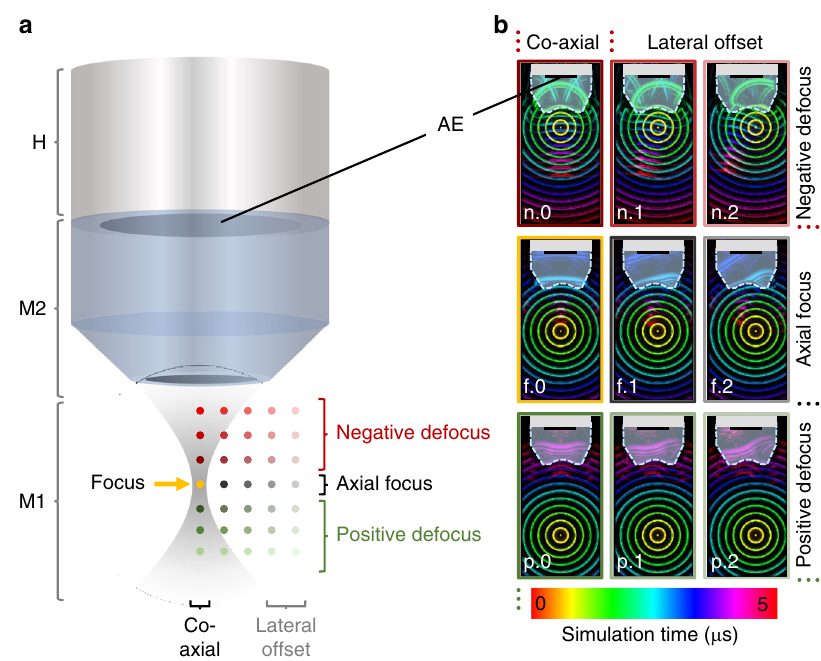
Fig. 4 Simulation scheme of the TIR for a spherically focused 50-MHz transducer. a The simulation grid of acoustic point sources consists of two materials M1 and M2 representing the actual settings and geometry of OR-optoacoustic microscopy utilizing a water-coupled spherically-focused transducer by means of a conically shaped plano-concave glass lens attached to the sensor. AE single active element, M1 medium 1 (water), M2 medium 2 (glass), H housing. b Representative visualization of TIR color-coded simulation time points for arrangements in axial focus (f.0 – 2), negative defocus (n.0 – 2), or positive defocus (p.0 – 2) at coaxial (*.0) and with lateral offsets (*.1 – 2). Only in the coaxial and axially focused case (f.0) does a plane wave reach the active element, whereas in axial and lateral offsets (all other panels), interference and wavefront distortion patterns can be